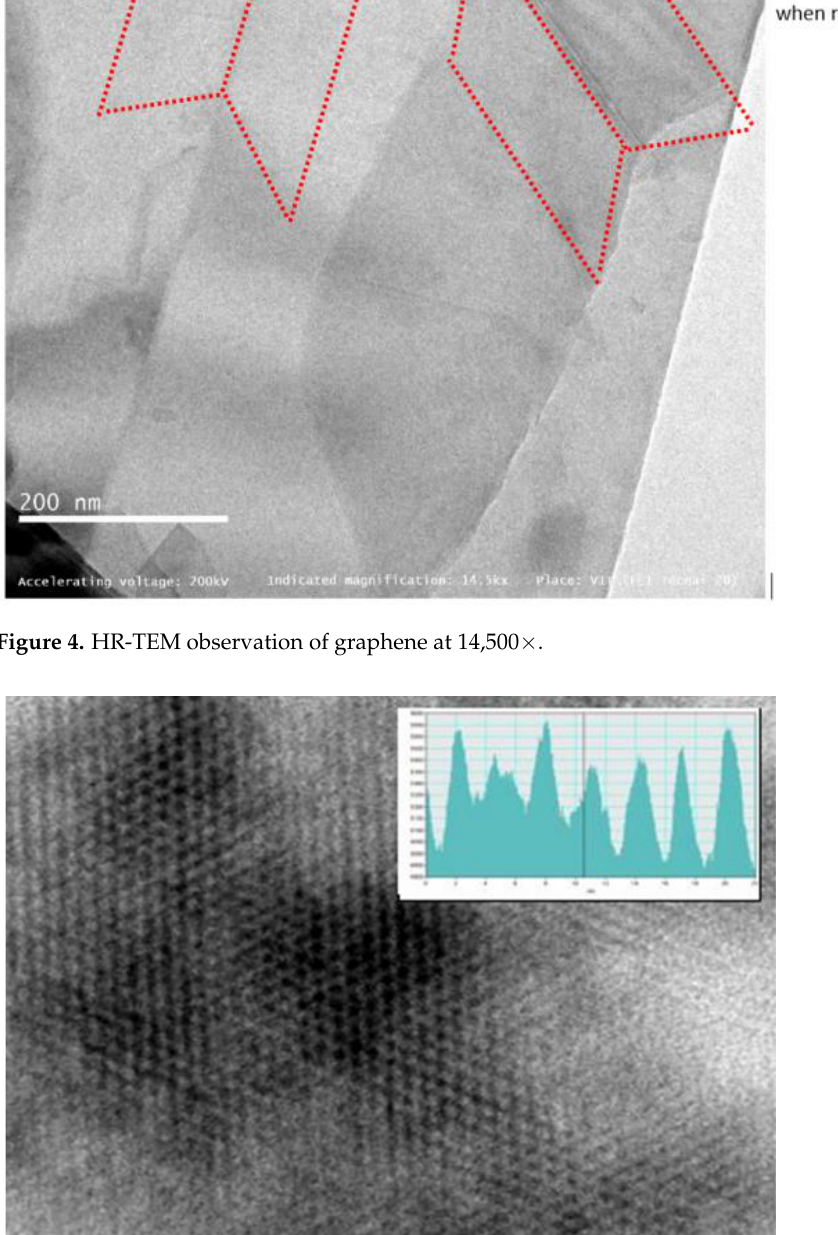
Figure 5. HR-TEM observation of graphene at 80,000×.